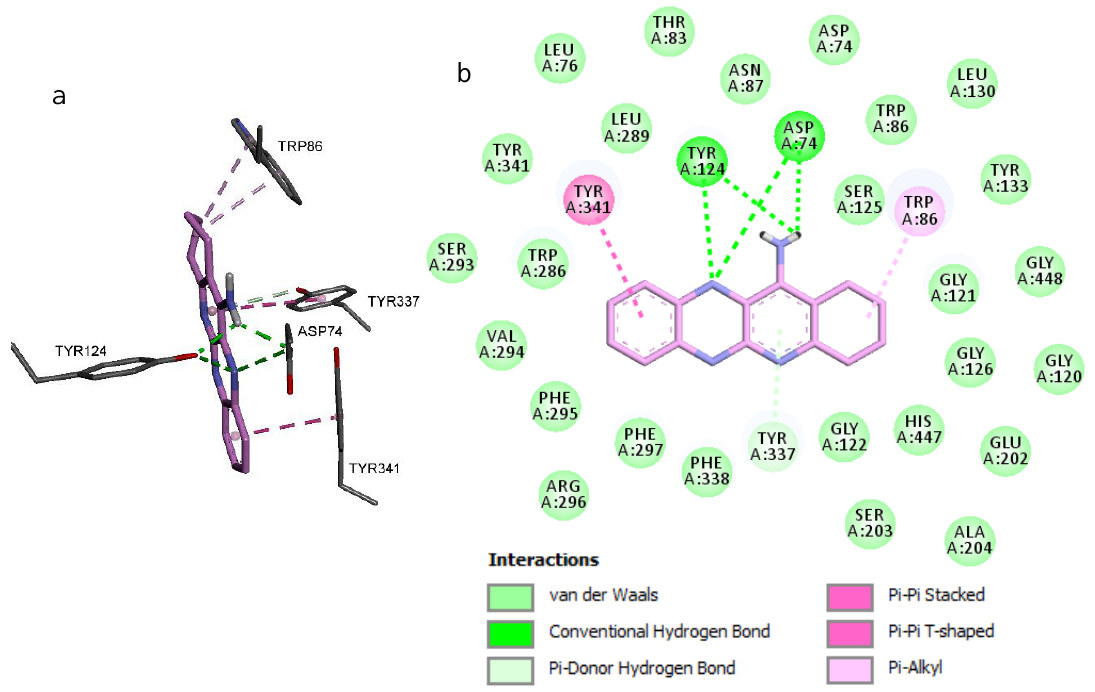
Figure 3. ( a ) Three-dimensional representation of interactions established by QT78 with hAChE. ( b ) Two-dimensional schematic view of the interactions between QT78 and hAChE.